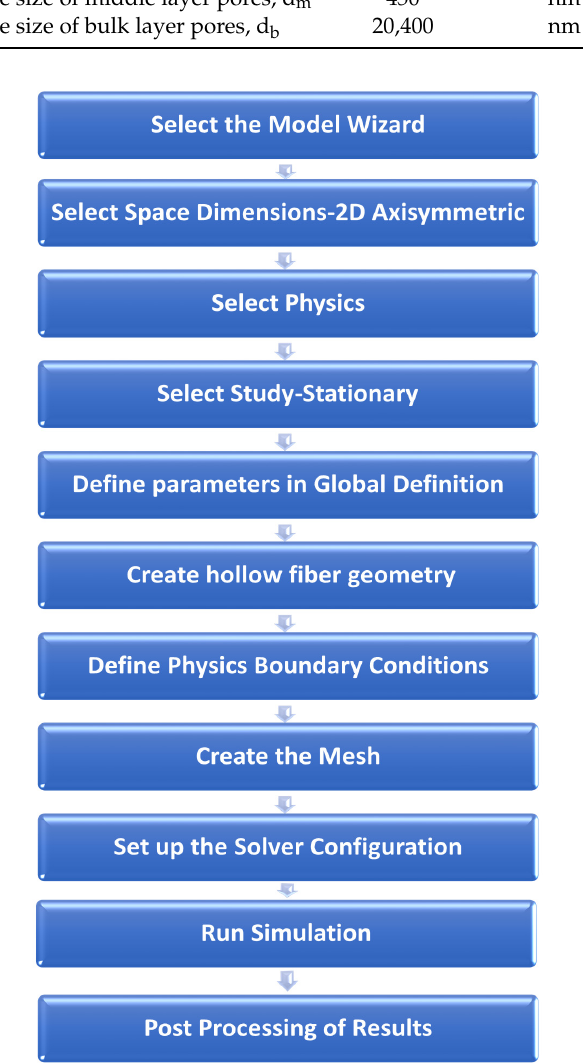
Figure 2. Simulation workflow in COMSOL Multiphysics 5.4.